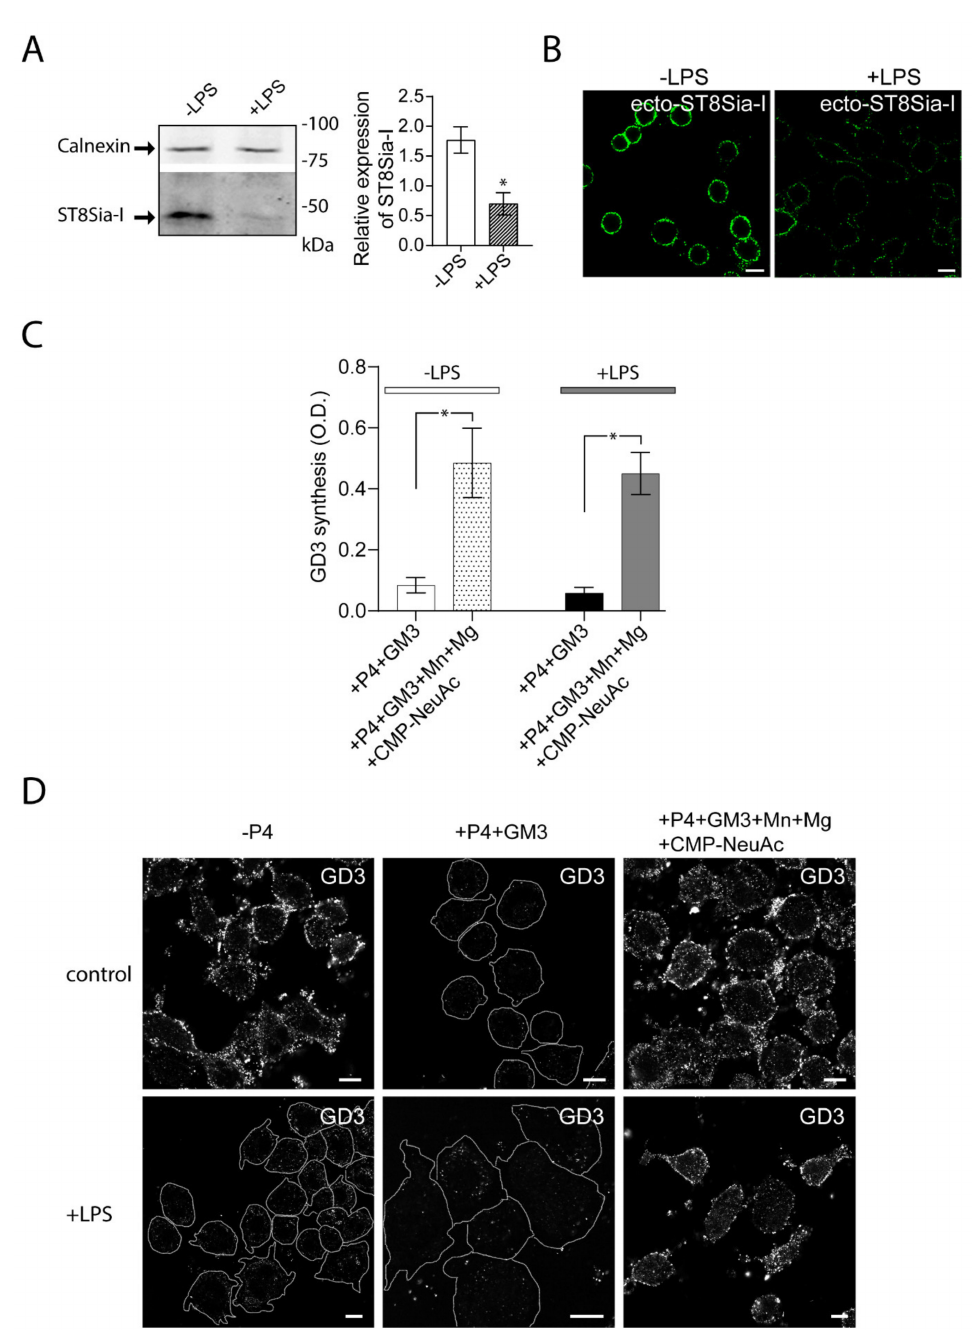
Figure 2. Reduced expression of ecto-ST8Sia-I and cis-activity of ecto-ST8Sia-I in Lipopolysaccharide (LPS) -stimulated macrophages. ( A ) Cell lysates of RAW264.7 cells stimulated ( + LPS) and non-stimulated (-LPS) with LPS for 48 h were analyzed by Western blot using an antibody specific for ST8Sia-I. Calnexin was used as a loading control. Data are representative for three independent experiments. Quantification of relative expression of ST8Sia-I is shown (bar graph; * p < 0.05). ( B ) Cells stimulated ( + LPS) and non-stimulated (-LPS) with LPS were immunostained with anti-ST8Sia-I antibody at 4 ◦ C for 60 min. Then, cells were fixed, incubated with secondary antibody and visualized by confocal microscopy. ( C ) RAW264.7 cells treated with P4 for 3 days were stimulated with LPS for 48 h. Then, cells were treated with 25 µ m GM3, washed, and incubated at 37 ◦ C in a medium containing only DMEM ( + P4 + GM3) or in a medium containing CMP-NeuAc, Mn + 2 and Mg + 2 . The P4 inhibitor remained present throughout the experiments. After 60 min, cells were washed and the GD3